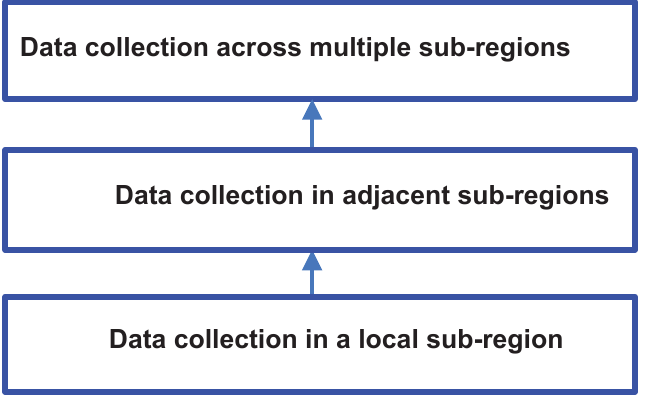
Figure 4. A three-layer distributed data collection framework.